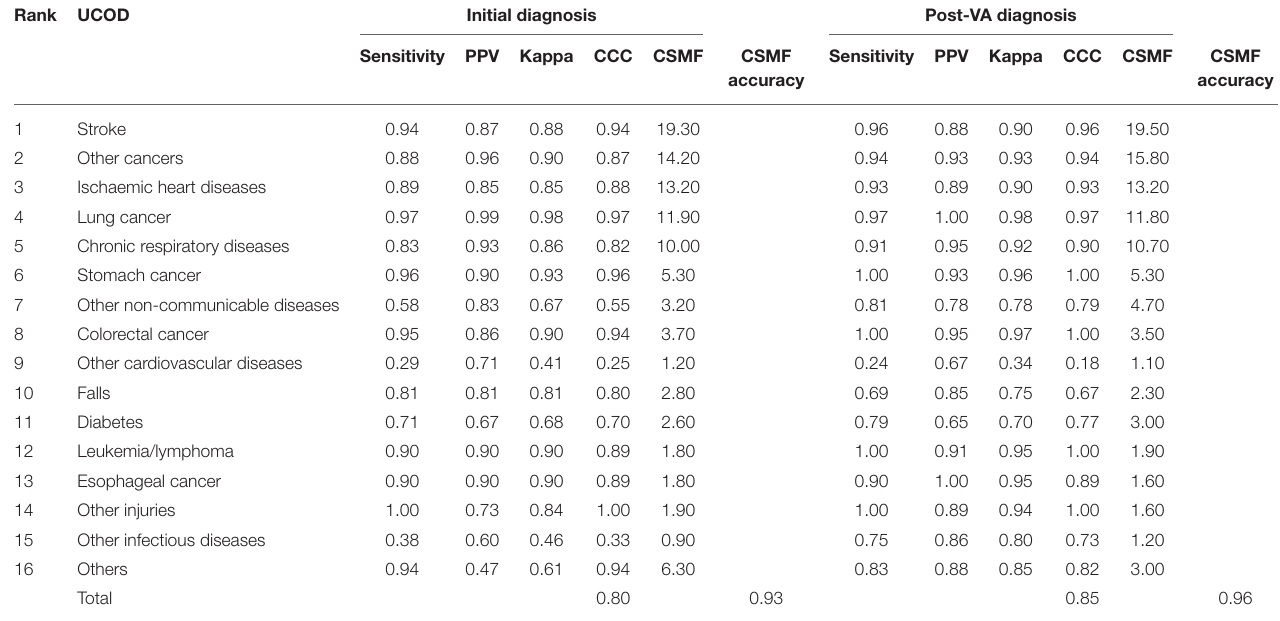
TABLE 3 | Validation metrics comparing initial diagnosis or post-VA diagnosis with Medical Record Review (MRR) underlying cause of death (UCOD) (top 15 specific UCOD). Rank